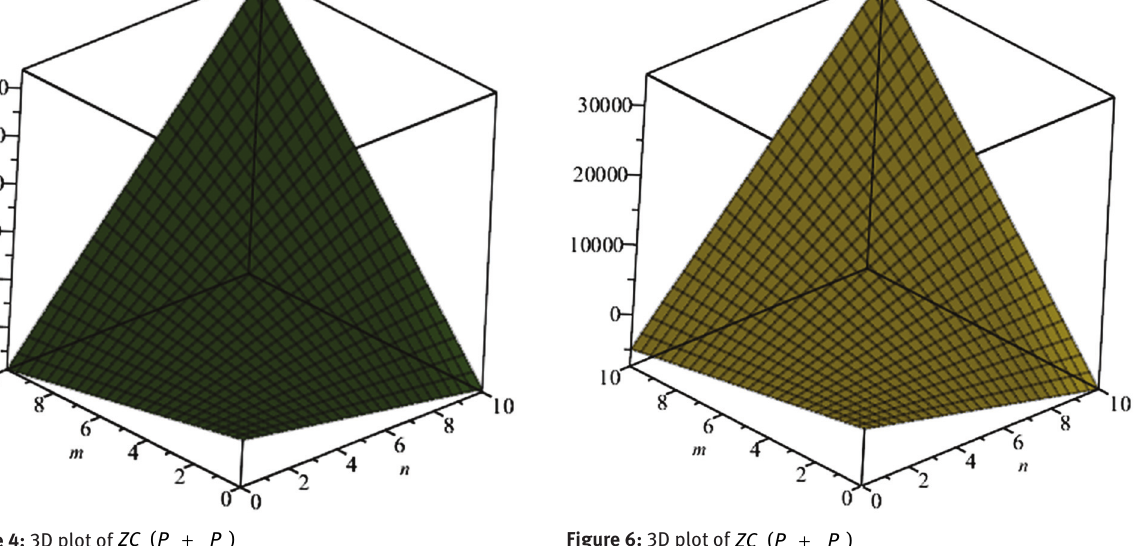
Figure 4: 3D plot of ZC P